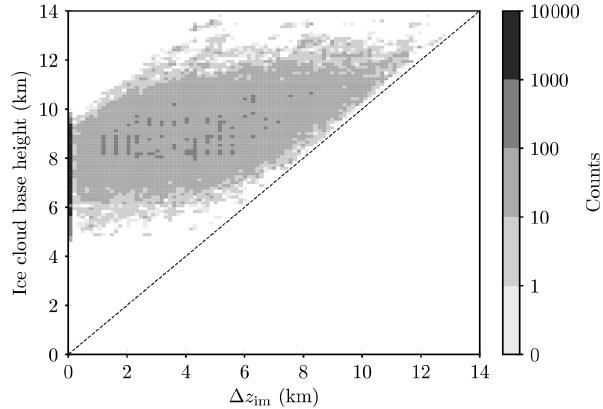
Figure B2. Distribution of icebase with (cid:49)z im